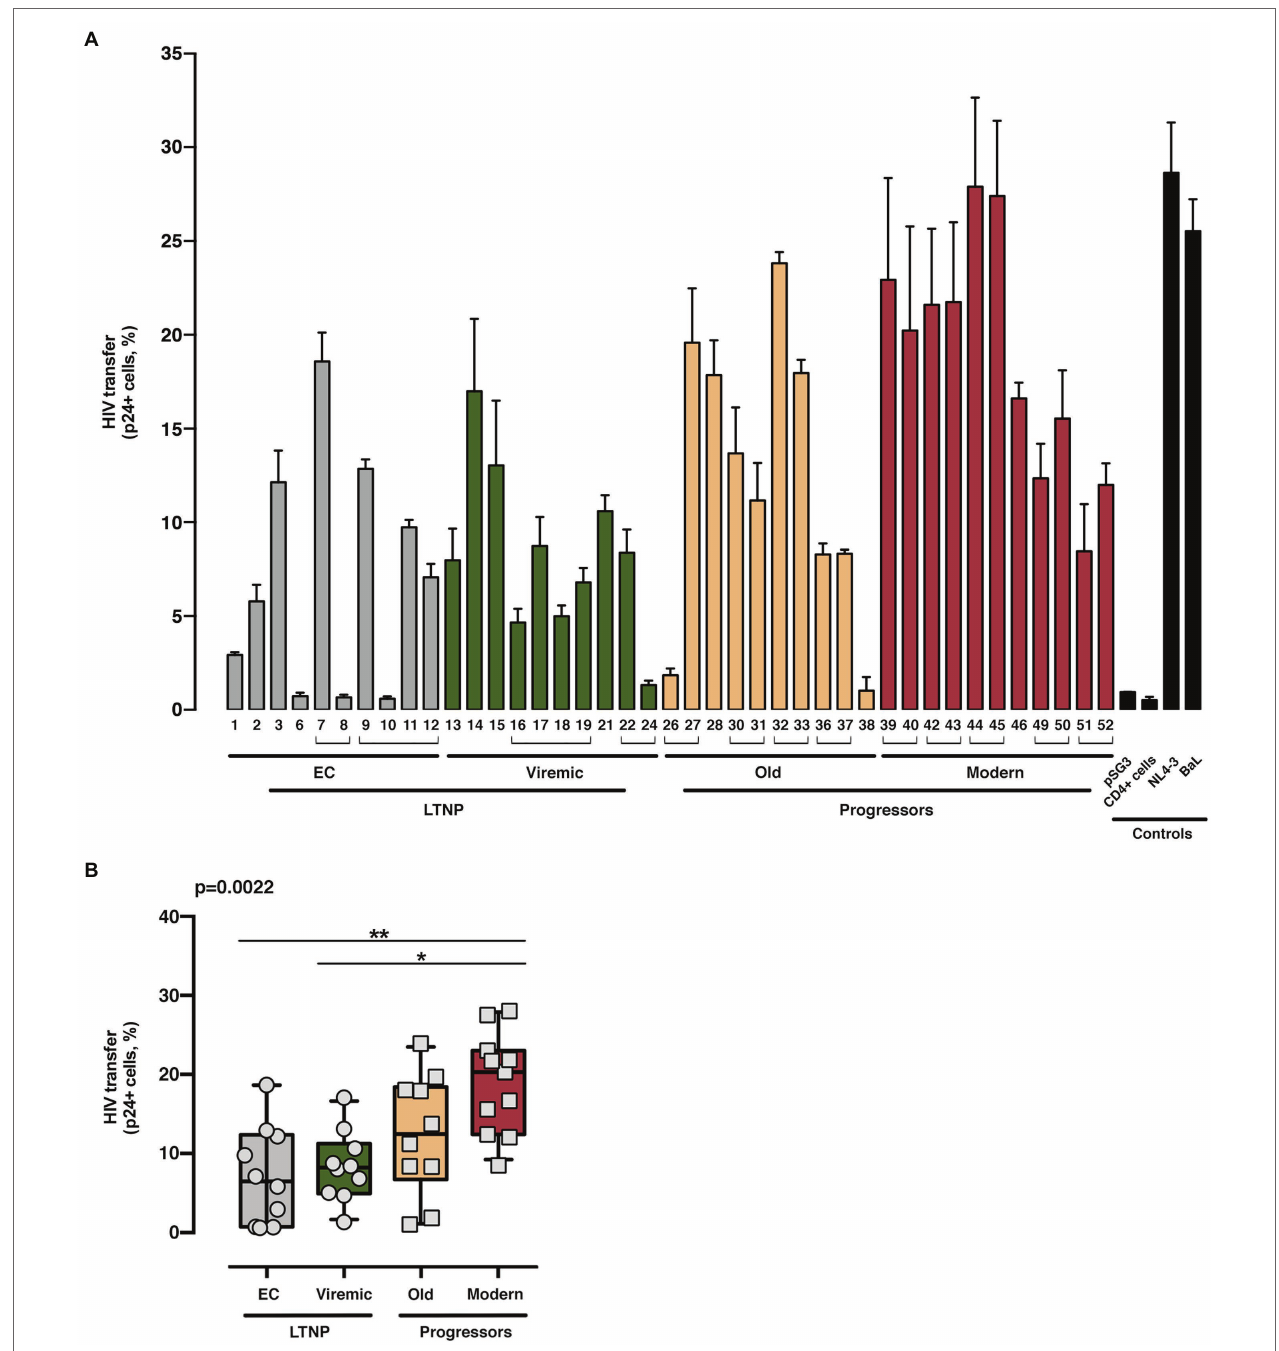
FIGURE 5 | Analysis of HIV-1 Env-mediated cell-to-cell viral transfer. Analysis of the ability to induce cell-to-cell virus transfer of HIV-1 Env proteins obtained from LTNP-EC ( gray bars ), vLTNP ( green bars ), Old Patients ( orange bars ), recent patients (Moderns; red bars ), or reference HIV-1 viral strains (pSG3, CD4 + cells, NL4.3, and BaL, black bars ). Analysis of HIV-1 Env-mediated cell-to-cell viral transfer for each patient (A) and in each group where values of p compare medians between groups using a nonparametric Kruskal–Wallis Test (Kruskal–Wallis, Dunn’s Multiple Comparisons Test; B ) are shown. Envs isolated from the same patient are associated with brackets in (A) ; value of p for comparison between all groups is shown, top left . p values are * p <0.01 and ** p <0.05. Values are mean ± SEM of two independent experiments ( n =